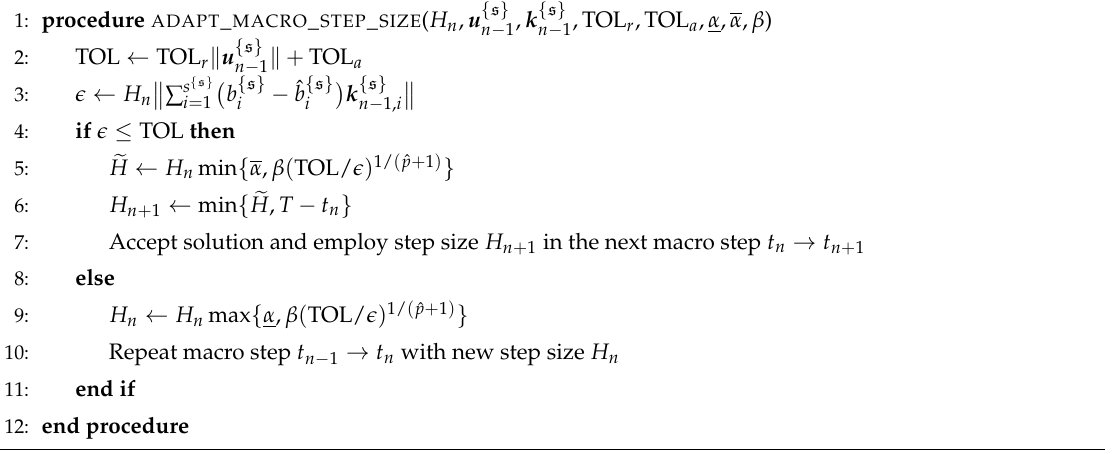
1 → t n with step size H n −